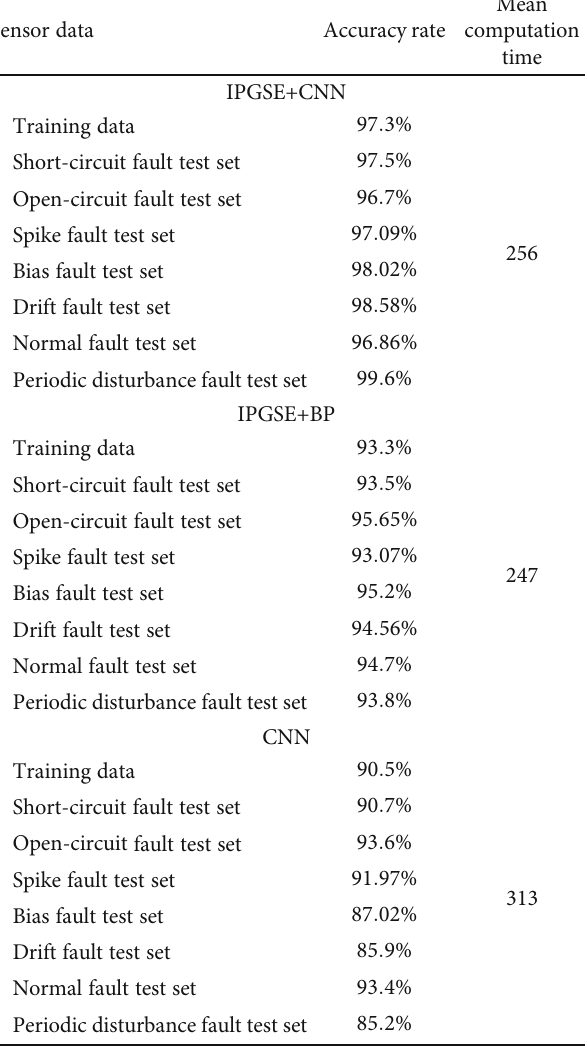
Table 4: Network parameters. Sensor